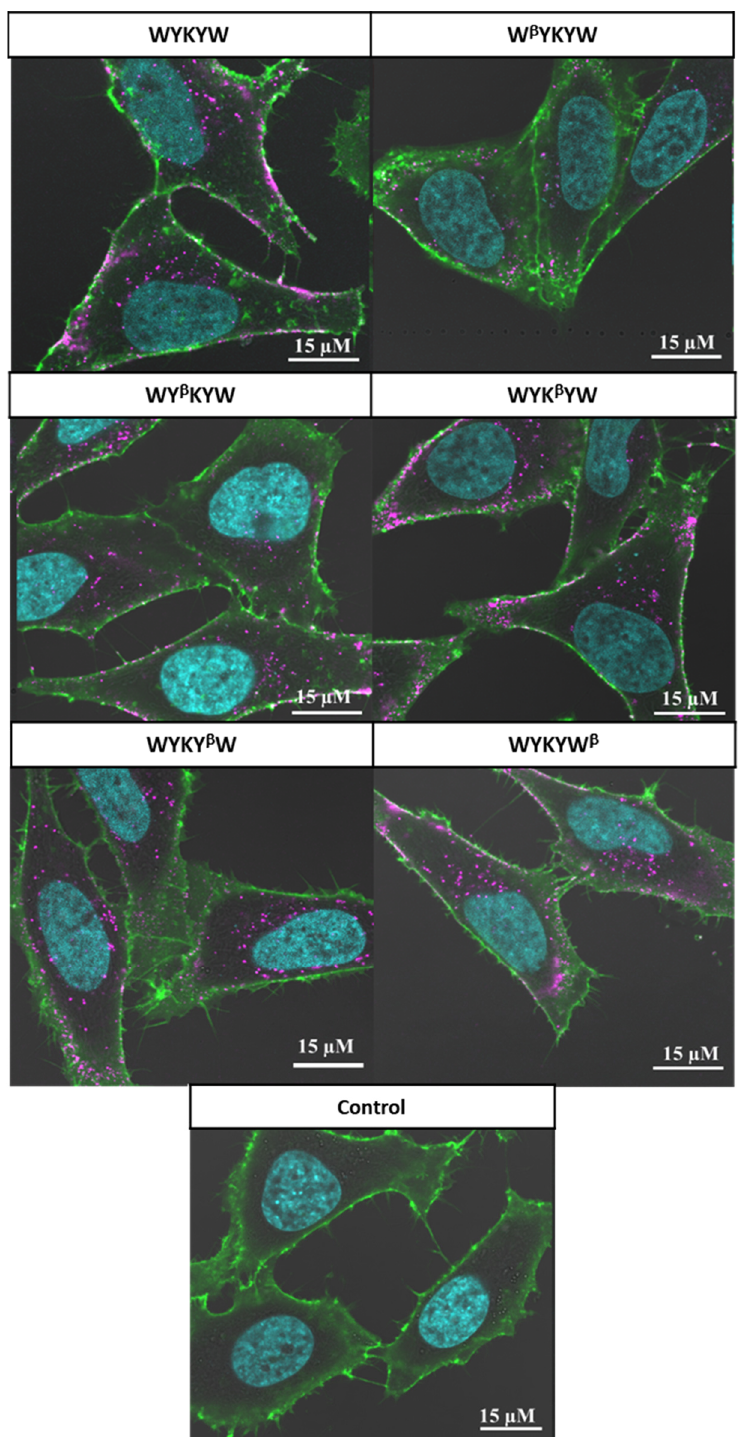
Figure 5. Delivery of the IgG cargo into HeLa cells, using the carrier WYKYW and its α , β -peptidic derivatives. The schematic representation of the carrier–cargo complex is given in Figure 4. Images are tagged by the carrier sequence measured ( β denotes the corresponding β 3 -amino acid). Alexa Fluor 647-conjugated secondary antibody is indicated in magenta; green staining defines cell membranes (WGA-FITC). Nuclei are indicated in cyan. The carrier–cargo complexes we applied at a concentration of 80 nM, and cells were incubated for 1 h. In the control measurement, cells were treated with IgG complex without the ganglioside-binding carrier peptides attached.